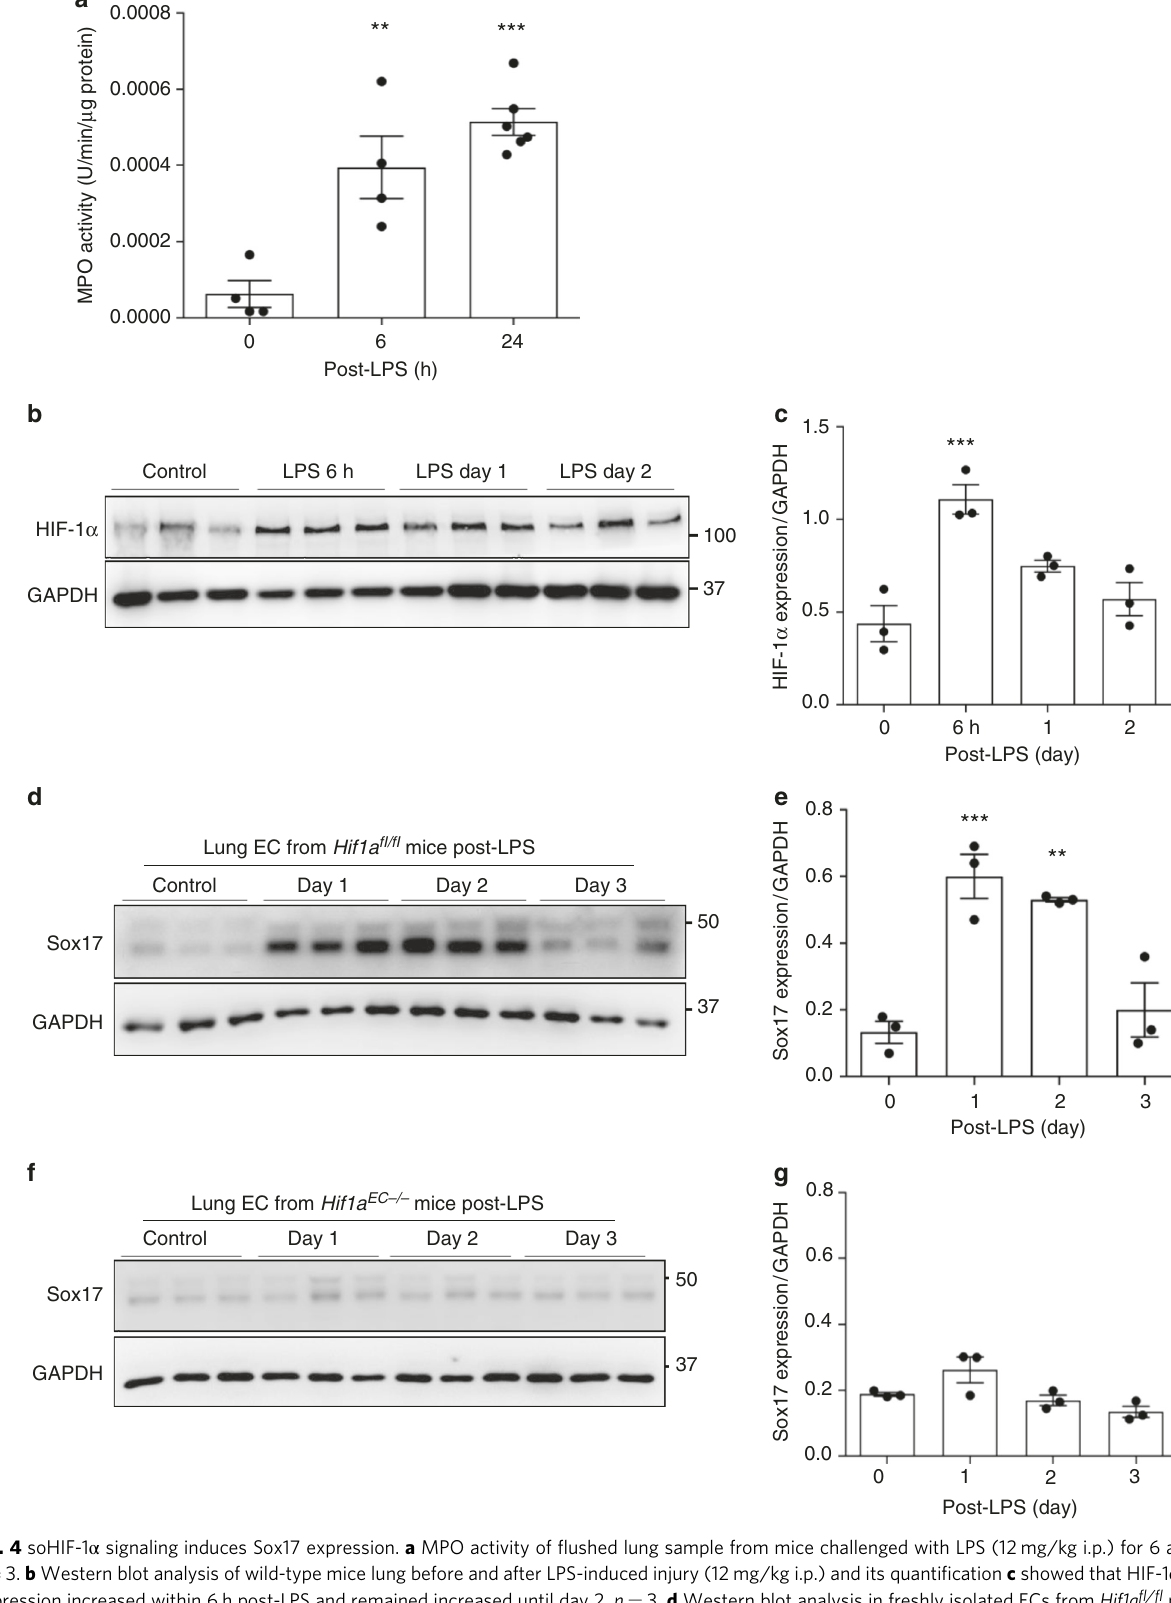
Fig. 4 soHIF-1 α signaling induces Sox17 expression. a MPO activity of fl ushed lung sample from mice challenged with LPS (12 mg/kg i.p.) for 6 and 24 h. n = 3. b Western blot analysis of wild-type mice lung before and after LPS-induced injury (12 mg/kg i.p.) and its quanti fi cation c showed that HIF-1 α protein expression increased within 6 h post-LPS and remained increased until day 2. n = 3. d Western blot analysis in freshly isolated ECs from Hif1a fl / fl mice and quanti fi cation e showed signi fi cantly increased Sox17 protein expression after injury when compared to baseline levels. n = 3. f Western blot analysis in freshly isolated ECs from Hif1a EC − / − mice and quanti fi cation g showed no signi fi cant difference in Sox17 protein expression before and after injury. n = 3. ** P < 0.01 and *** P < 0.001. Data are shown as mean ± SEM. Analysis was performed using one-way ANOVA for ( b , c , e , g